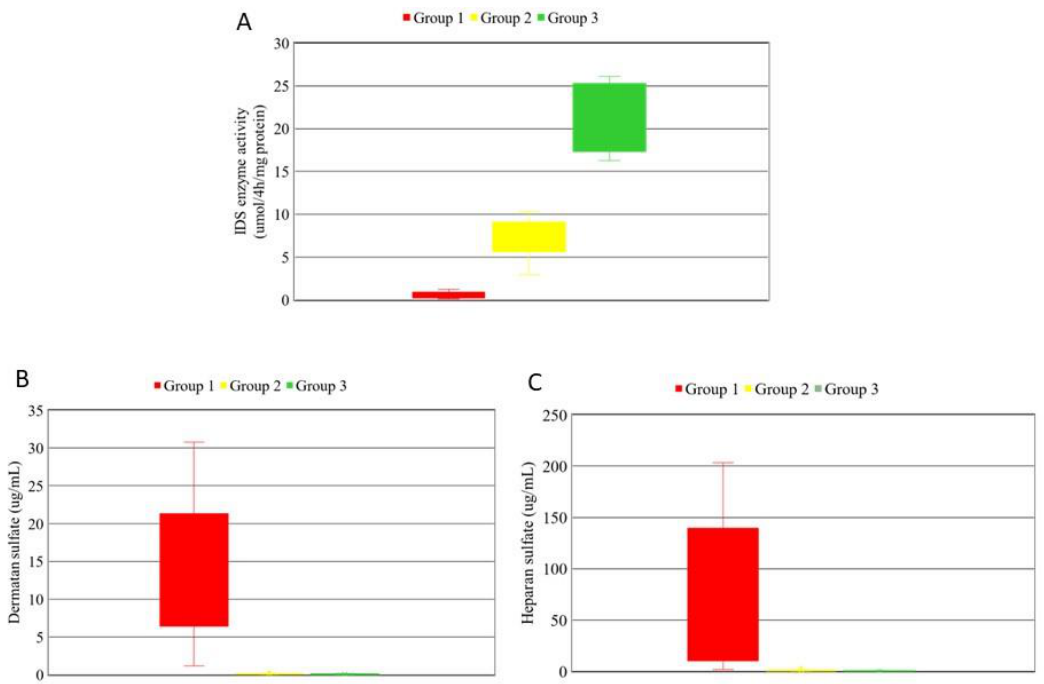
Figure 3. The IDS enzyme activity ( A ), urinary dermatan sulfate ( B ), and urinary heparan sulfate ( C ) quantities for the subjects of the three diagnostic groups. IDS, iduronate-2-sulfatase.